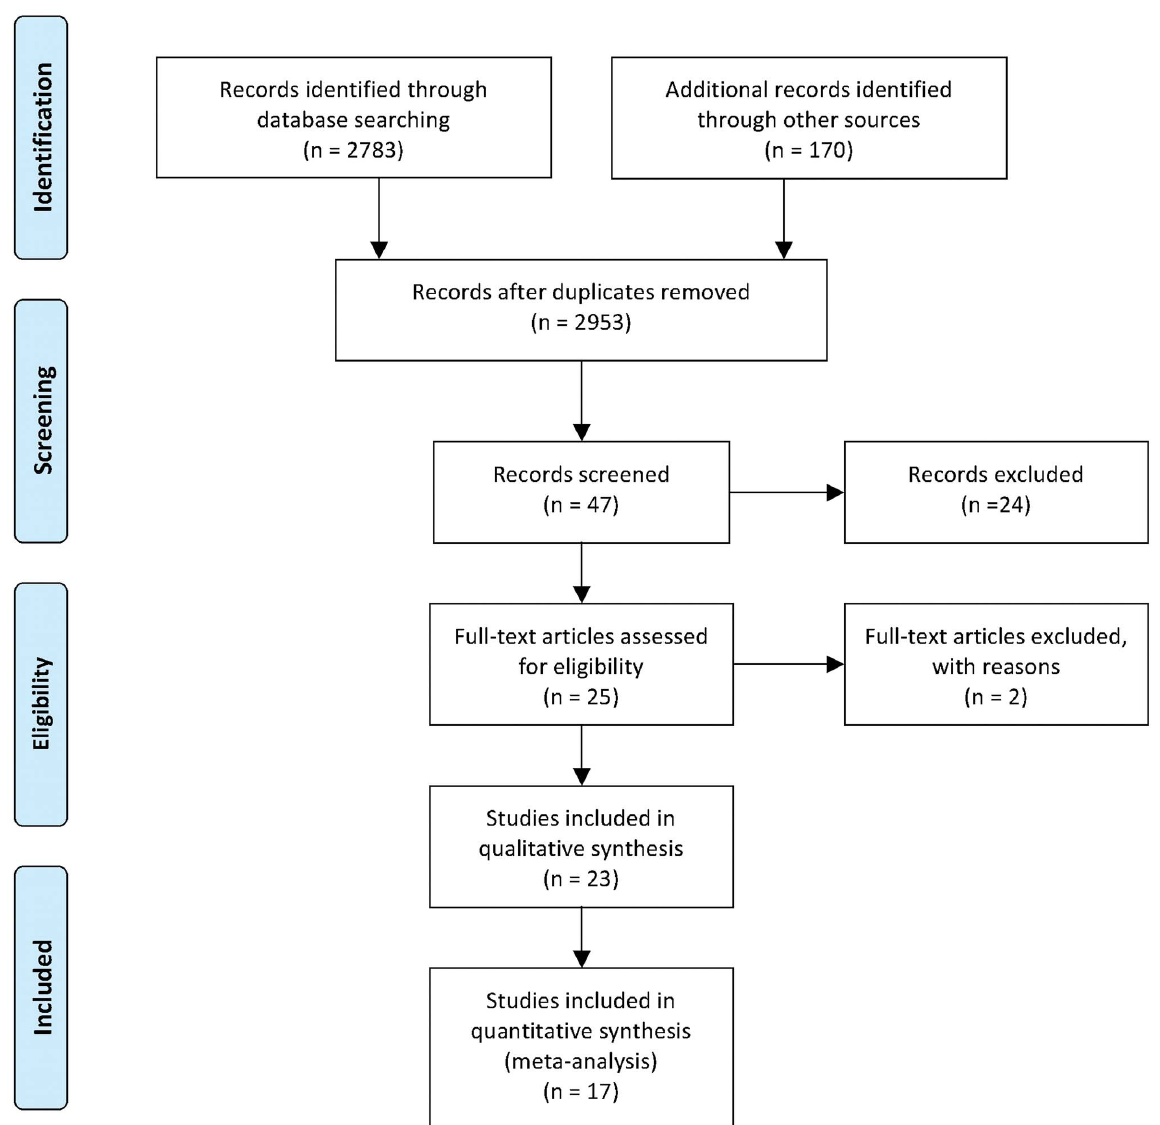
Figure 1. Summary of the search strategy and selection process based on included and excluded studies.